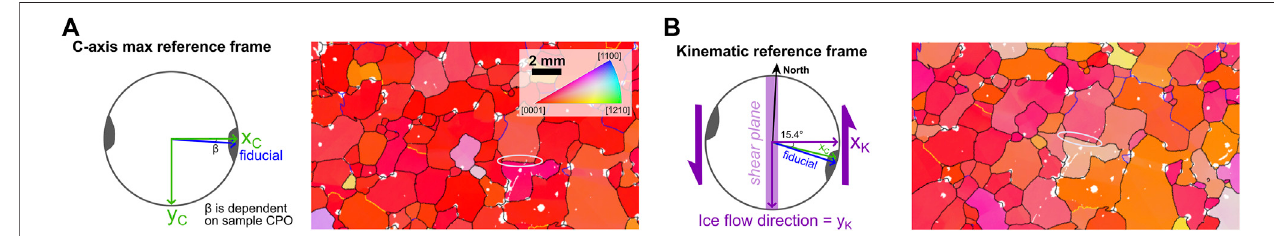
FIGURE 5 | The two reference frames used in this paper. (A) The “ c -axis maximum ” reference frame, where the x axis is aligned with the sample c -axis maximum. (B) The “ kinematic ” referenceframe,where the y axisisalignedwiththeglacier fl owdirection,parallel withtheshearplane asindicatedbythepurplearrows. Inall fi gures the pixels are colored with an inverse pole fi gure scheme (inset in A) that shows which crystal direction lies parallel to the x direction of the reference frame. Red is c -axis ( (cid:2) [0001])parallel tox,greenisa-axisparalleltox.Whitepixels arenotindexeddue tolimitationsofEBSDacquisition.Blacklines aregrainboundaries. Whiteellipse shows the same grain boundary segment in both EBSD maps highlighting rotations between the two reference